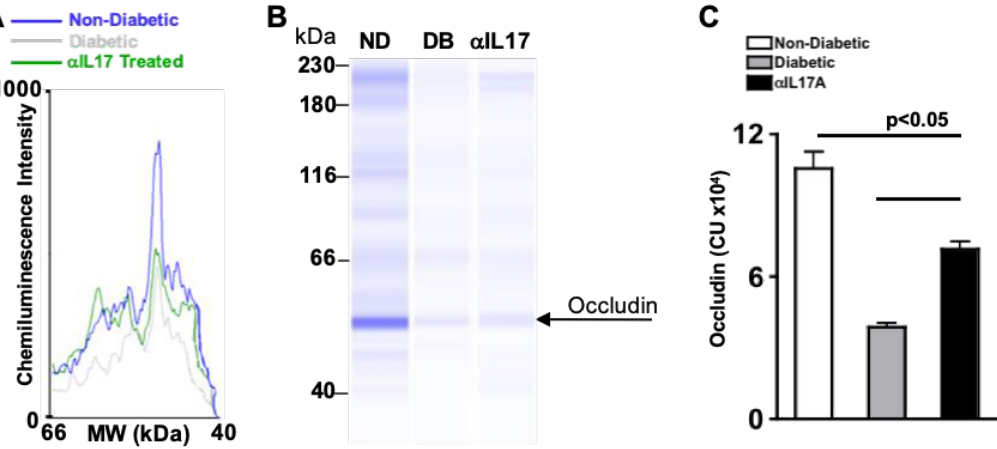
Figure 7. Occludin Degradation in anti-IL-17A treated db/db Diabetic Mice 6 Months Post-Diabetes. ( A ) Representative electropherogram of Occludin in retinal protein lysates of non-diabetic (blue), untreated db/db diabetic (grey), and anti-IL-17A treated db/db diabetic (green). ( B ) Wes gel of Occludin in retinal protein lysates of non-diabetic (ND), untreated db/db diabetic (DB), and db/db diabetic mice treated with 50 µ g/mL of anti-IL-17A ( α IL17); 6 months post-diabetes. ( C ) Occludin protein quantification in retinas of non-diabetic (white), untreated db/db diabetic (grey), and db/db diabetic mice treated with intraperitoneal injections of anti-IL-17A (black). Error bars represent the SEM. All p-values were first equated using 2-way ANOVA and then unpaired student’s t -test with Tukey’s post-hoc analysis. Data are represenetative of 3 separate Wes analyses.